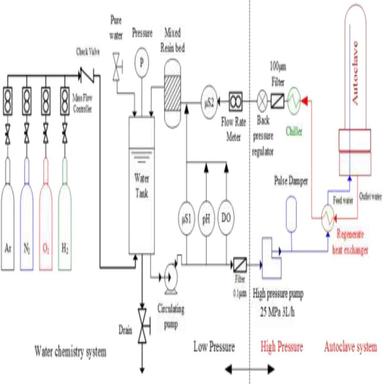
Schematic of the high-temperature corrosion test system.